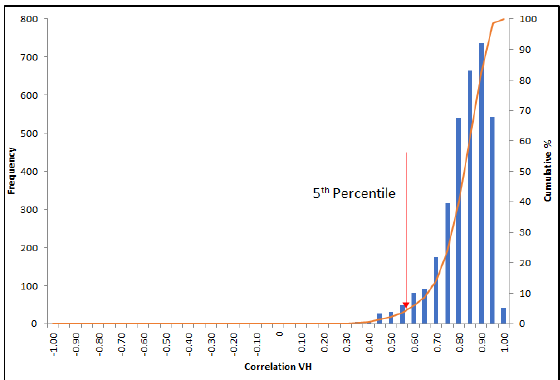
Figure 7. Training data VH correlation